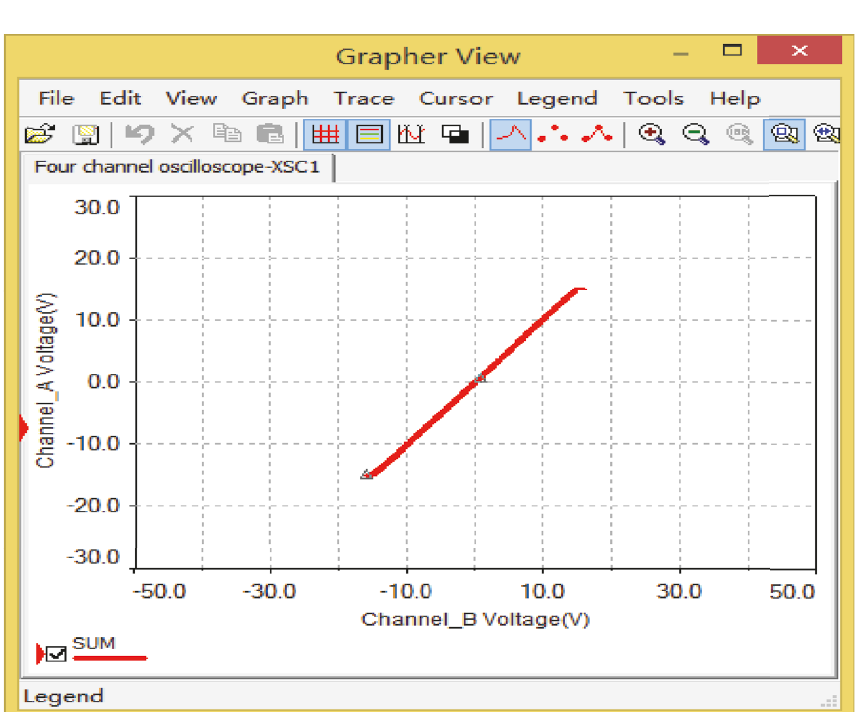
Figure 20: Synchronous phase portrait of 16